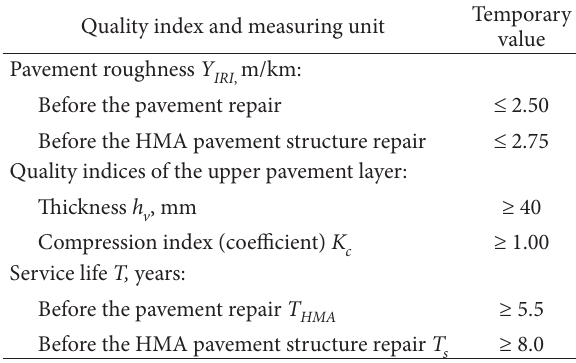
Table 3 . The values of HMA pavement and its structure condition of the Lithuanian roads and the recommended values of quality indices Quality index and measuring unit